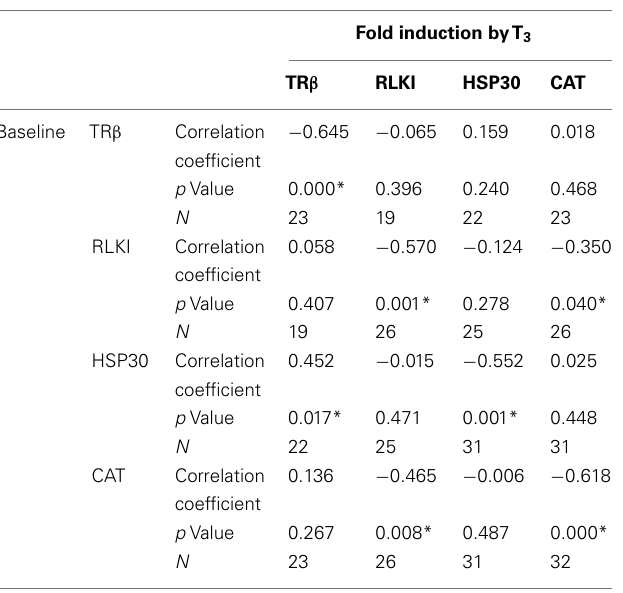
Table 1 | Spearman’s rho correlation analysis comparing baseline transcript levels with extent of (fold) induction in response toT 3 treatment.